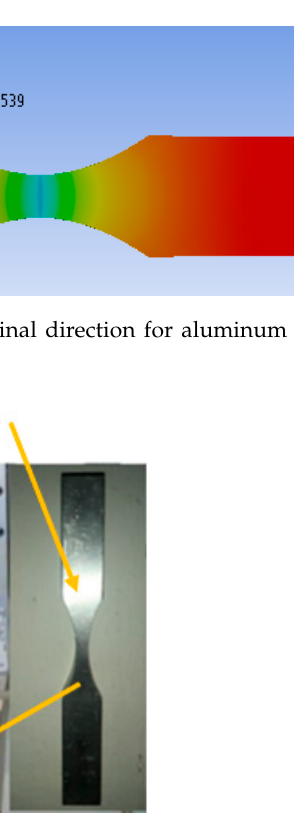
Figure 1. ( a ) Ultrasonic fatigue specimen dimensions (mm), fitting the resonance condition; ( b ) dimensions (mm), of the conventional fatigue specimen.